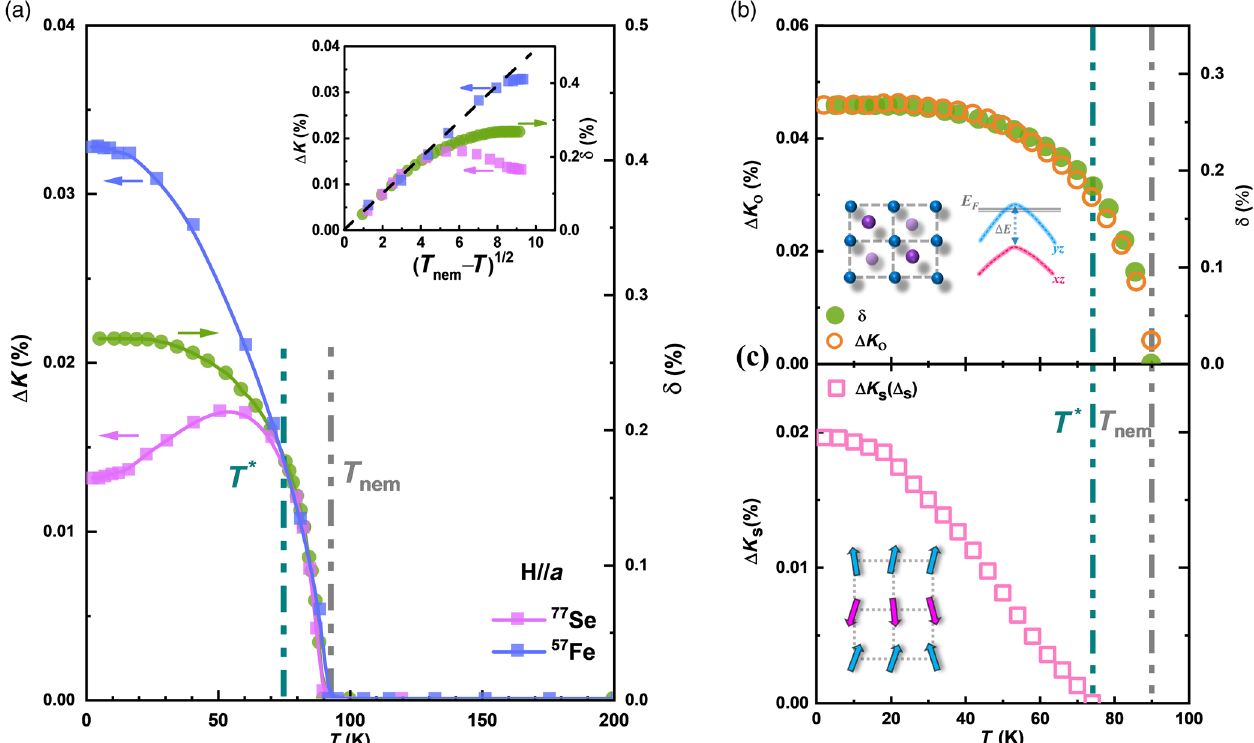
FIG. 3. Knight-shift evidence for a sizable anisotropy in spin space: Temperature-dependent splitting of the Knight shift. (a) Temperature evolution of the in-plane Knight-shift anisotropy of 57 Fe and 77 Se. The experimental data are shown as solid light-blue squares ( 57 Fe) and solid light-magenta squares ( 77 Se). The T -dependent lattice orthorhombicity δ ð T Þ ( δ ¼ ð a − b Þ = ð a þ b Þ ) measured through synchrotron high-energy x-ray diffraction in Ref. [42] is also reproduced with solid dark-green circles. The inset (top − T Þ 1 = 2 ) . right) shows the proportional relationship in the proximity of the second-order phase transition: ( Δ 57 K; Δ 77 K; δ ð T Þ ∝ ð T nem The discrepancy below T (cid:3) is also clearly shown. Below about 20 K, all three quantities are saturated. The solid lines are guides for the eye. (b) The temperature-dependent Δ K o ð T Þ and lattice orthorhombicity δ ð T Þ . The Δ K o ð T Þ and δ ð T Þ are marked as open orange circles and filled green circles. [The data are interpolated from panel (a)]. The inset shows the cartoon picture for the orbital-related band splitting and orthorhombic structural distortion. (c) The temperature-dependent Δ K s ð T Þ (or anisotropy of the local-spin susceptibility). Interestingly, the Δ K s ð T Þ starts to arise only below T (cid:3) instead of immediately below T . The inset shows a cartoon depiction of the nem anisotropic spin polarization in the Ising nematic state. The extracted Δ K s ð T Þ is interpolated from the original data shown in panel (a) with spline interpolation